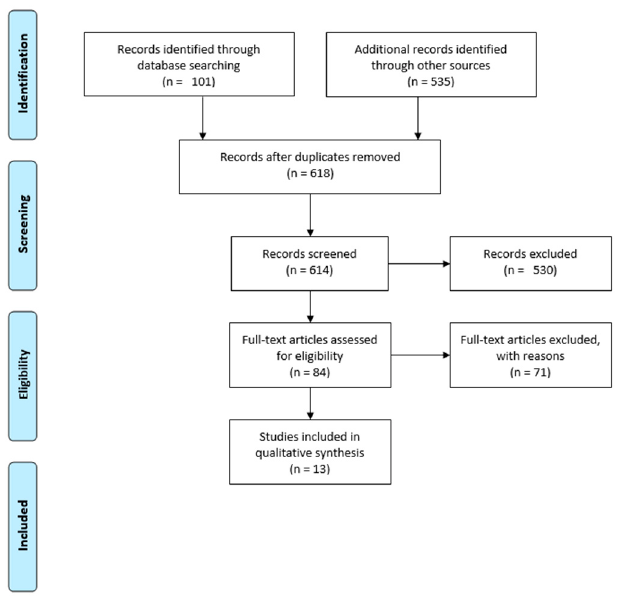
Figure A2. PRISMA 2009 Flow Diagram—Willingness [85]. For more information, visit www.prisma-